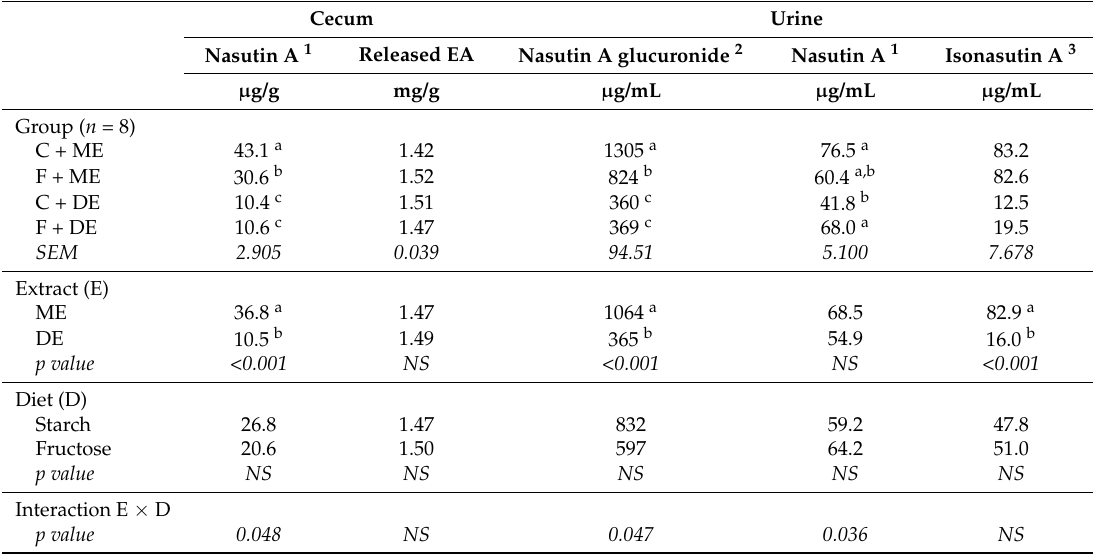
Table 6. Ellagitannin metabolite profile in the cecal digesta and in the urine of rats fed experimental diets